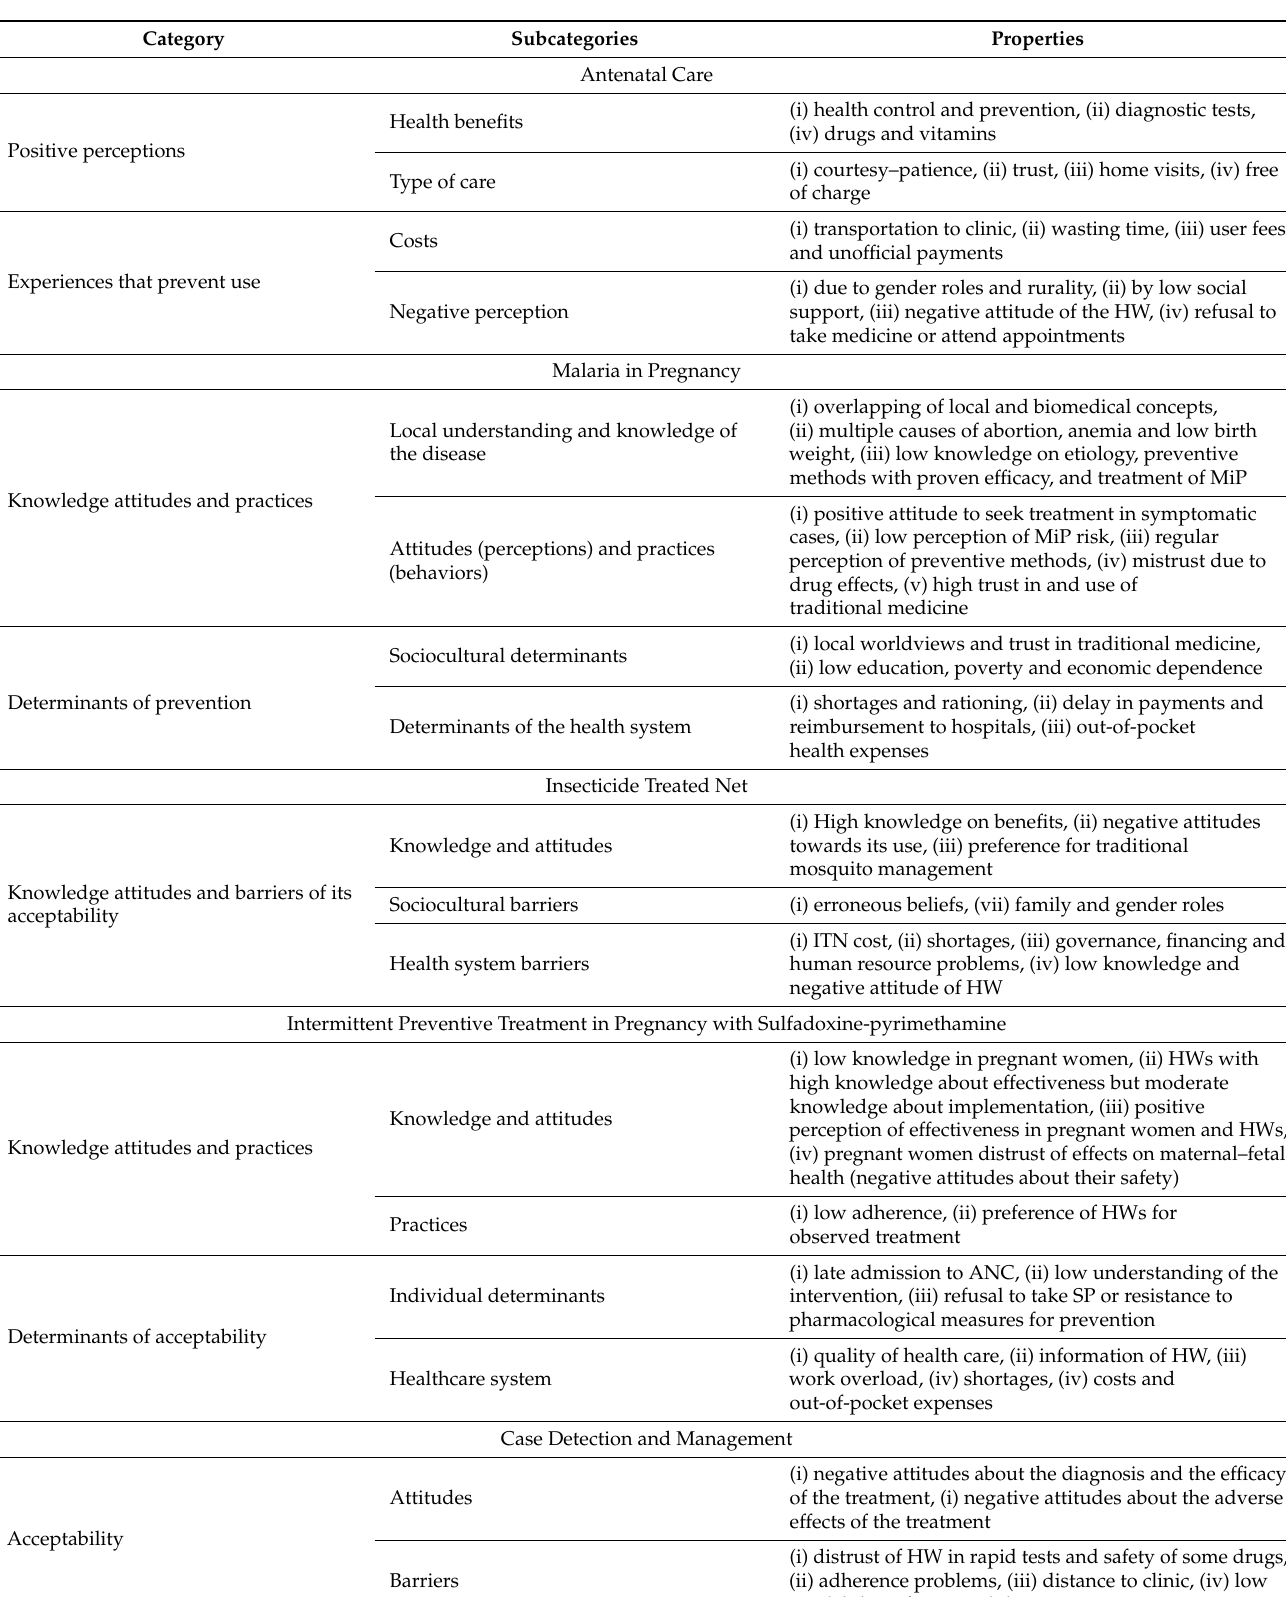
Table 2. Categorial system according to the research